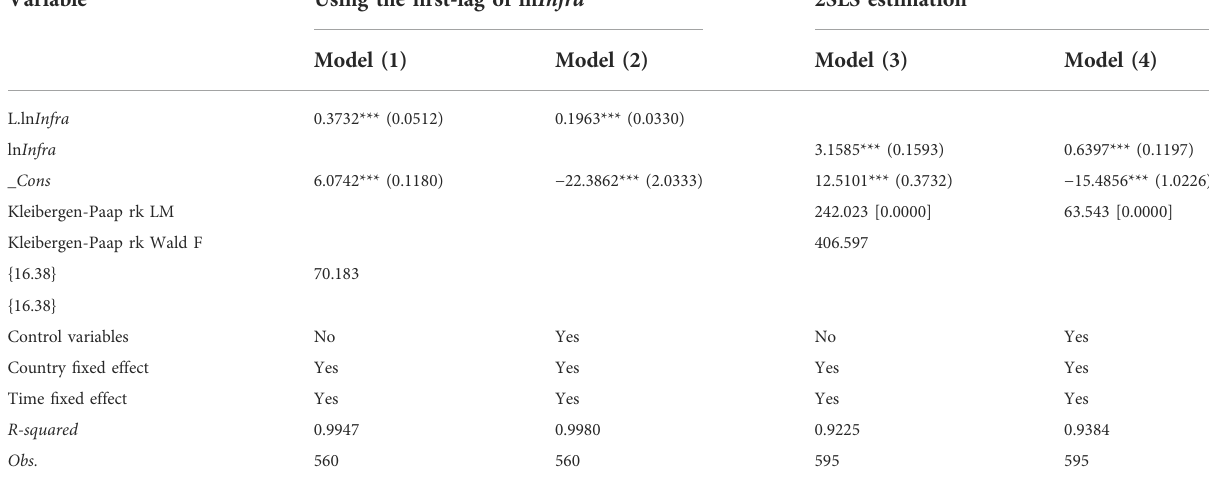
TABLE 7 Results of addressing endogeneity issues. Variable Using the fi rst-lag of ln